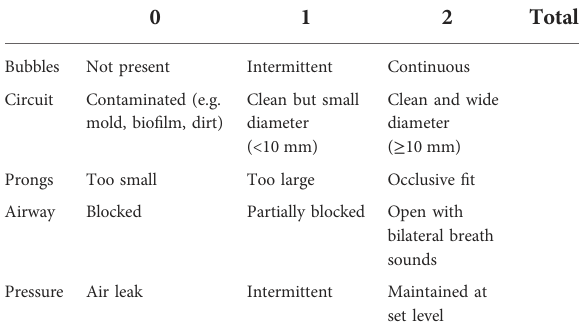
Table re-used with permission from Oxford Press. “ Contaminated ” refersto the presence of mold, bio fi lm, dirt,